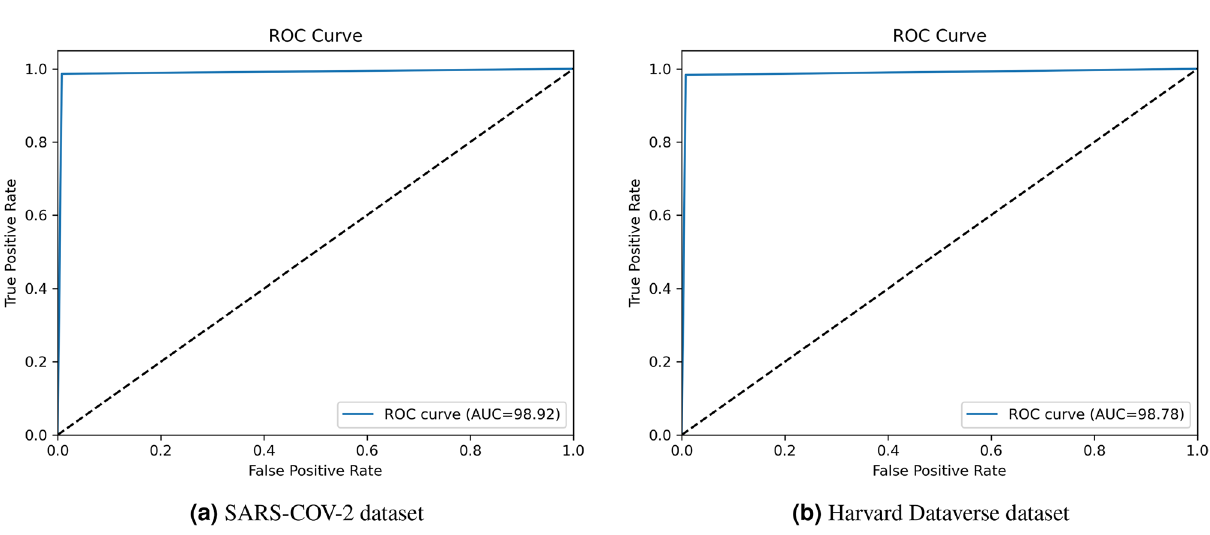
Figure 4. ROC curves obtained by the proposed ensemble model on the two